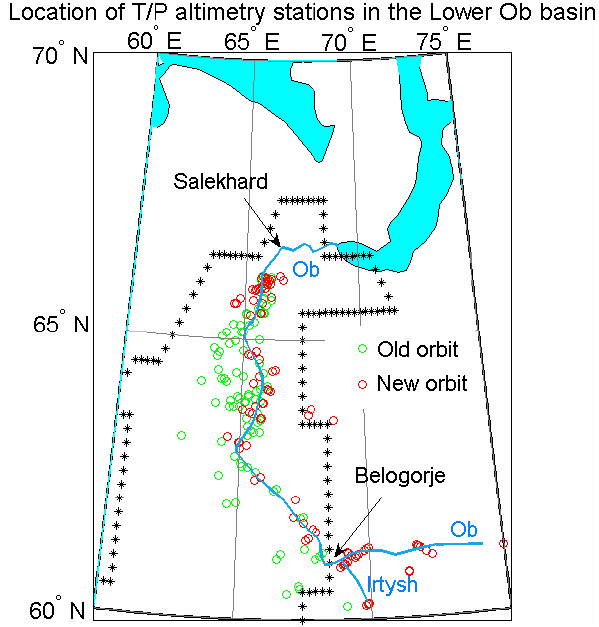
Fig. 1. Map of Lower Ob’ Basin and locations of the Figure 1. Map of Lower Ob’ basin and locations of the Topex/Poseidon water level stations. 1 Topex/Poseidon water level stations. The line with stars shows the The line with stars shows the delineation of the watershed. 2 delineation of the